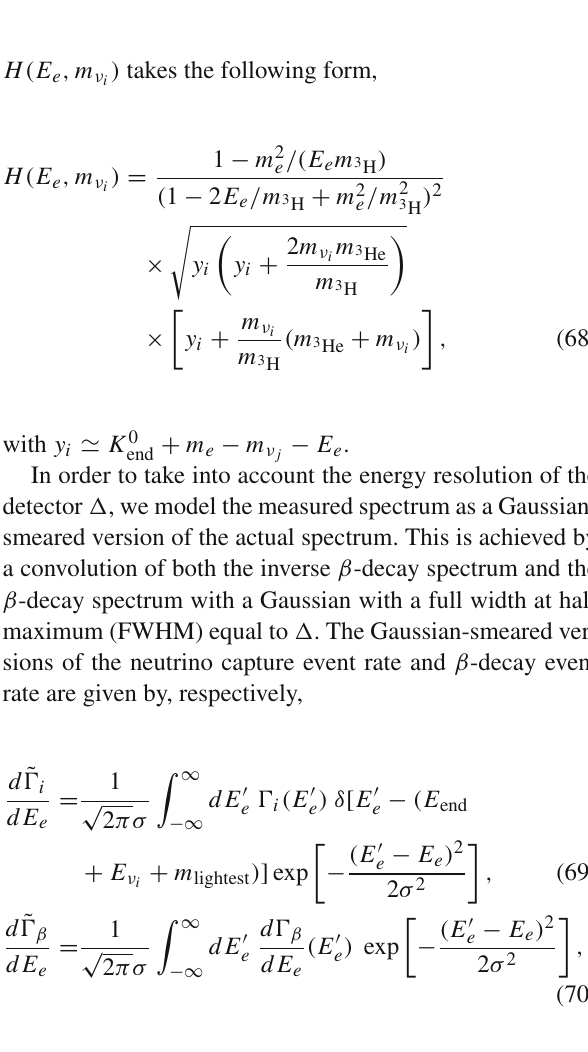
the neutrino decoupling, using the results of Ref. [6], but neglect the gravitational clustering effect since the lightest neutrinos are expected not to be affected by the gravitational